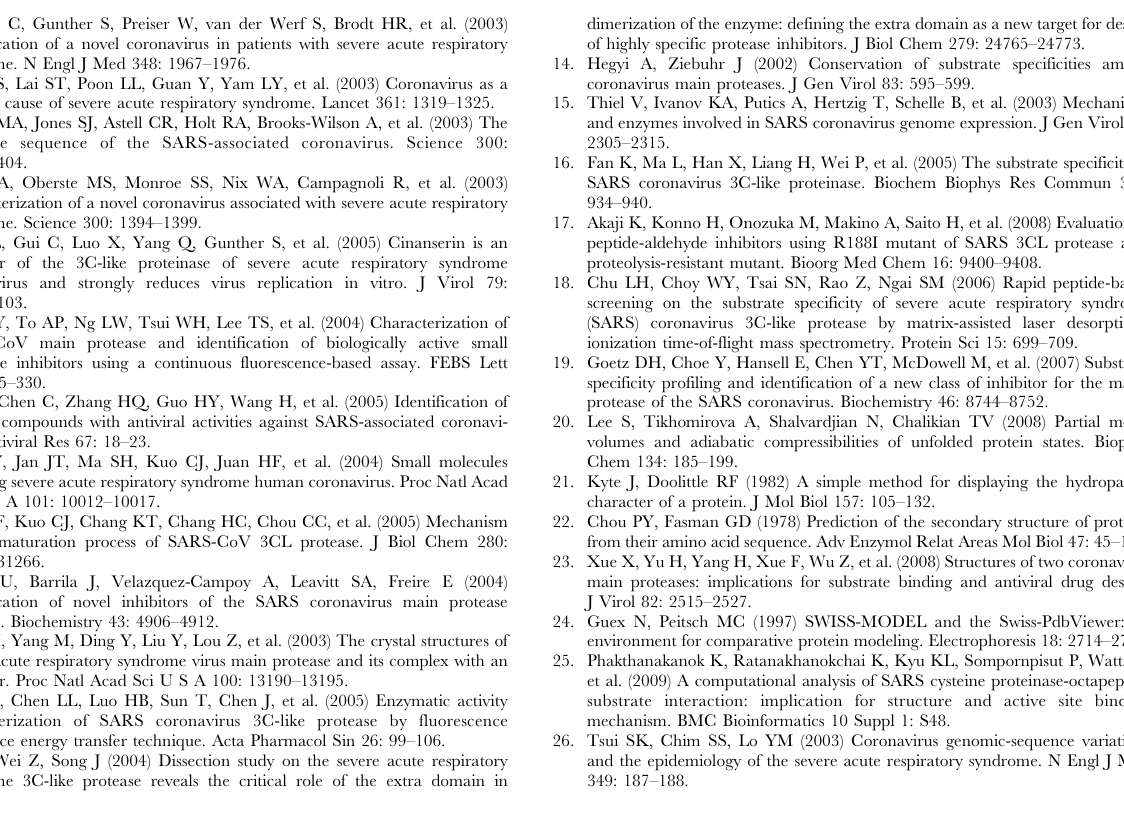
Table S1 SARS-CoV 3CL pro relative activity on the substrate variants. ‘ND’ stands for non-detectable cleavage.